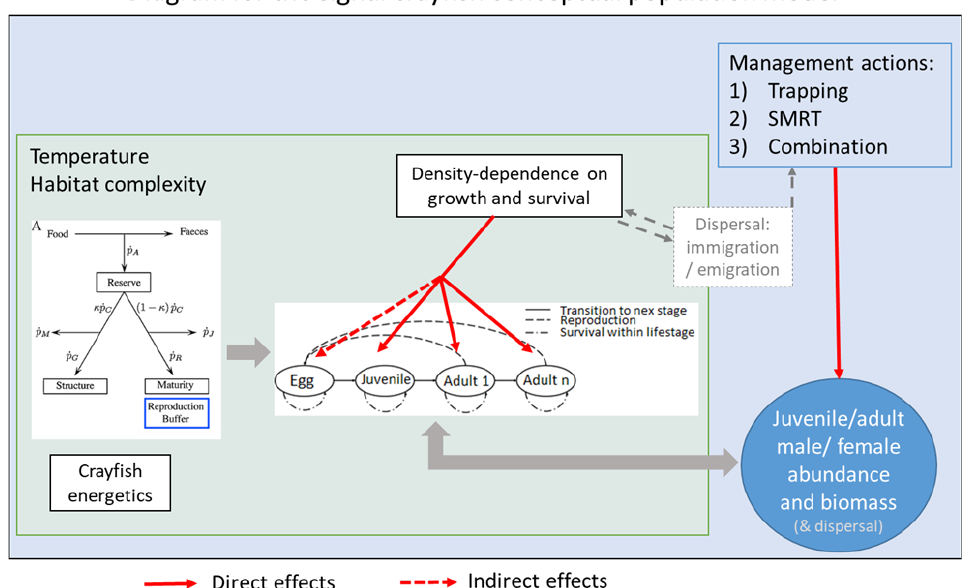
Figure 2. Diagram of the signal crayfish conceptual model. Crayfish life history and life cycle result from underlying DEB processes which are driven by external temperature. Density-dependence is based on population size and habitat complexity, i.e., shelter availability, and its impacts are size-dependent, but not stage-specific. Several management actions will impact the age- and size structure of the population, as well as the overall abundance and biomass. These changes feed back to the population model, mainly through the density-dependent functions. Density-dependent effects and the efficacy of different management options will be affected by dispersal. Even though dispersal is not the integral part of the model, consequences of implemented management actions on dispersal rates will be explored in model analysis.